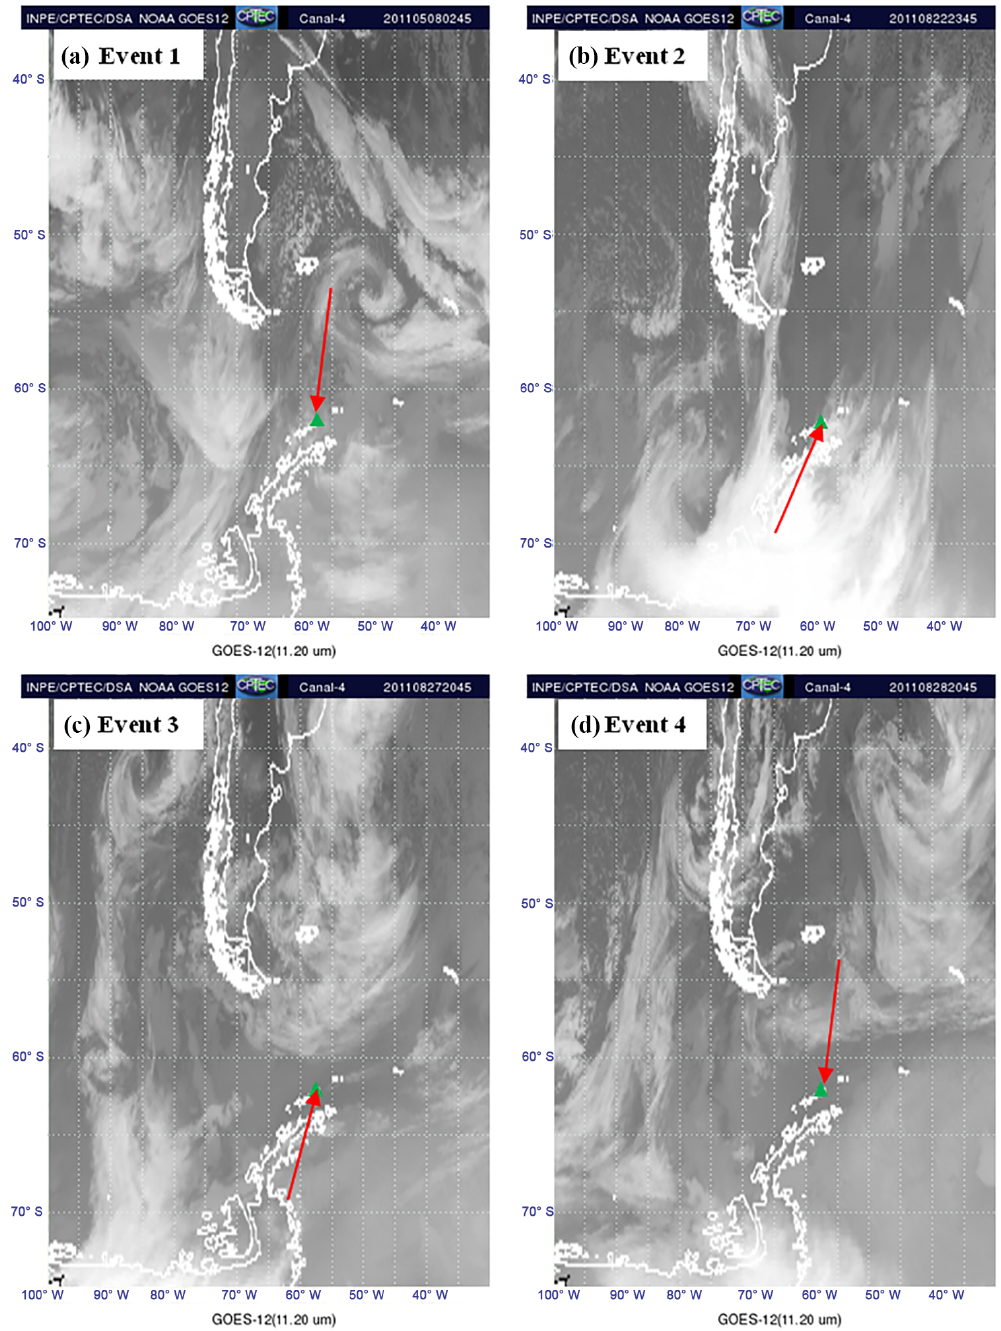
Figure 9. Satellite images before the mesospheric observations. The green triangle represents the position of Ferraz Station and the arrows represent the direction of the front propagation. Event 1 occured approximately 5 hours before the observation of the front, Event 2 about 3 hours before the observation, Event 3 about 2 hours before the observation, and Event 4 about 4 hours before the observation. Source: Center for Weather Forecasting and Climate Studies of the National Institute for Space Research